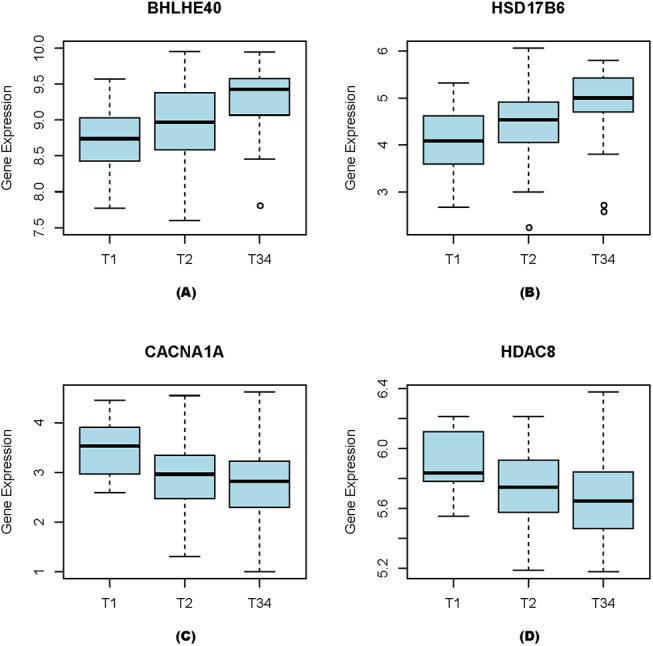
Correlation between gene-expression levels and three grades of breast cancer.(A) BHLHE40, (B) HSD17B6, (C) CACNA1A, and (D) HDAC8.